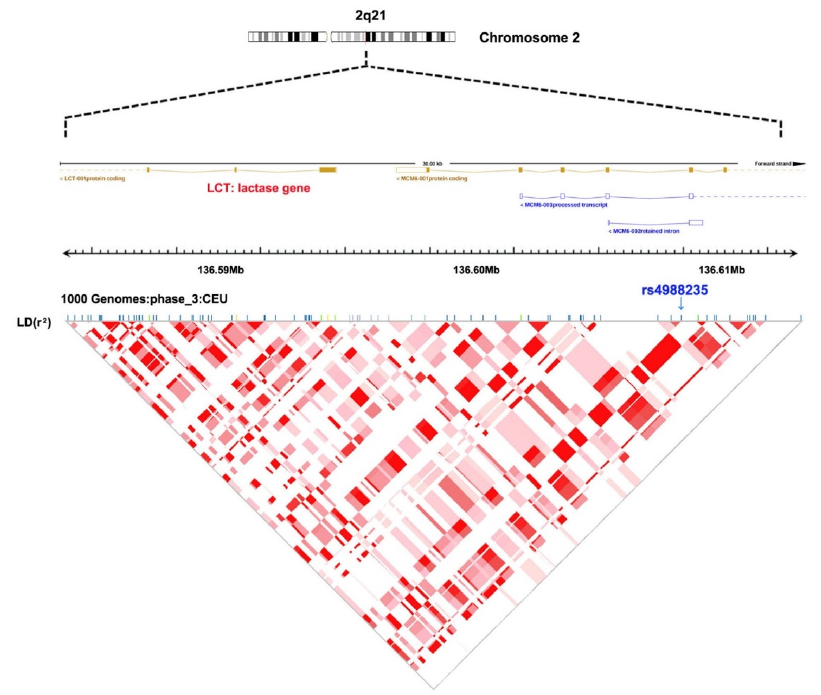
Figure 2. Rs4988235 on chromosome 2q21 and linkage disequilibrium pattern of single-nucleotide polymorphisms based on 1000 genomes (phase_3,